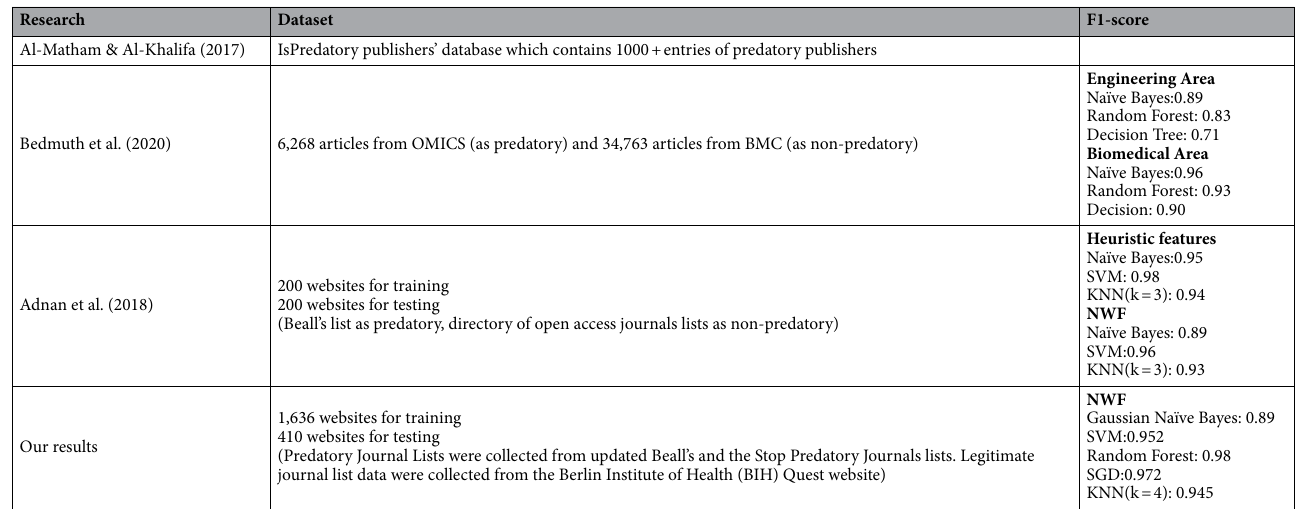
Table 6. Different researches classification method and